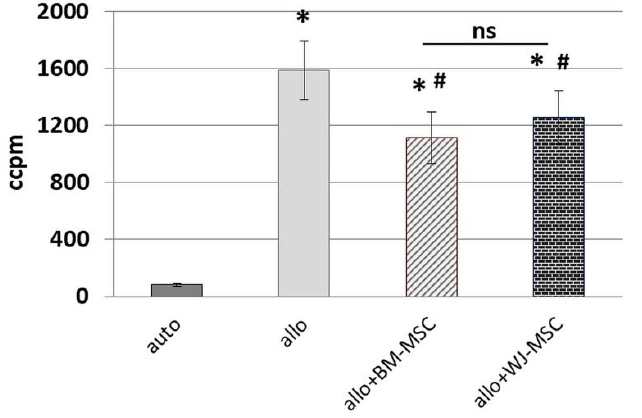
Figure 2. The effect of BM-MSCs and WJ-MSCs on the allo-stimulated lymphocytes proliferation. The graph presents the results of the Mixed lymphocytes reaction (MLR) assay. Auto—the proliferation of lymphocytes stimulated with irradiated lymphocytes from the same donor. Allo—proliferation of lymphocytes stimulated with irradiated lymphocytes from the unrelated donor. Data presented as means (± SEM). * p < 0.001, in comparison to the “auto” group (T-test for related data); # p < 0.01, comparison to the “allo” group (T-test for related data). The effect of different MSC types on lymphocytes was compared using the U Mann–Whitney test. ns—statistically not significant. PBMCs from 10 donors were used (5 pairs), each combined with one BM-MSCs ( n = 5) and one WJ-MSCs ( n = 5) population. Total n = 10 for each MSC type.